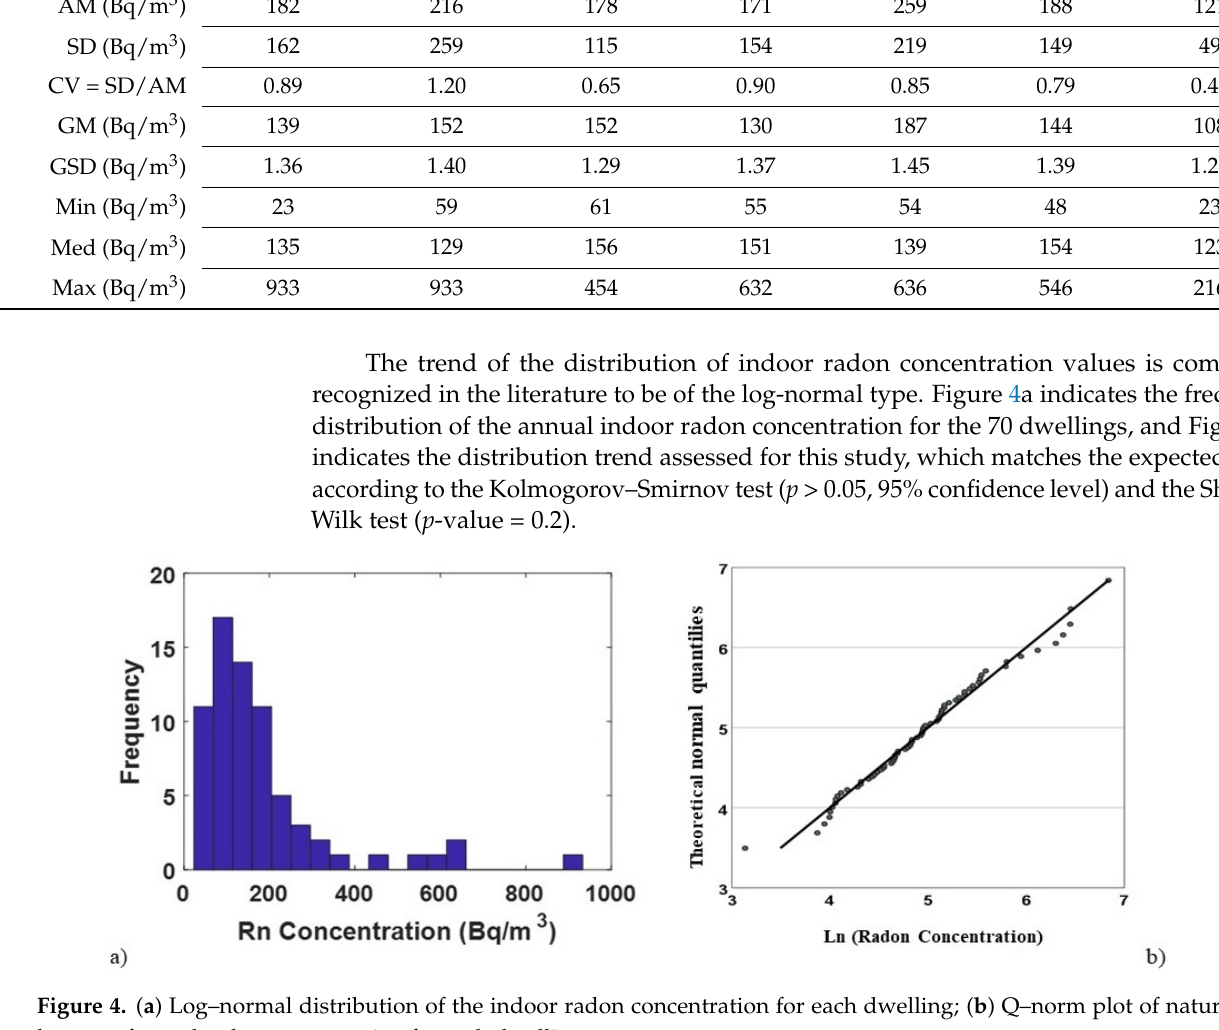
Figure 4. ( a ) Log – normal distribution of the indoor radon concentration for each dwelling; ( b ) Q – norm plot of natural log-transformed radon concentration for each dwelling. Approximately 13% of the measurements made exceed the reference level of 300 Bq/m 3 established by the Italian Legislative Decree 101/2020, which transposes the European Directive on Fundamental Safety Standards (BSS)-2013/59 [9]. Soil is thought to be the primary source of indoor radon. Unfortunately, the study was unable to evaluate the relationship between radon concentrations and the geological features of the soil on which the structures were erected. A correlation study, however, was performed using the municipality as the soil ′ s proxy variable. Figure 5 depicts a box plot of Rn concentration in Bq/m 3 by municipality. The analysis of variance (ANOVA) method was used to compare different groups (municipality).